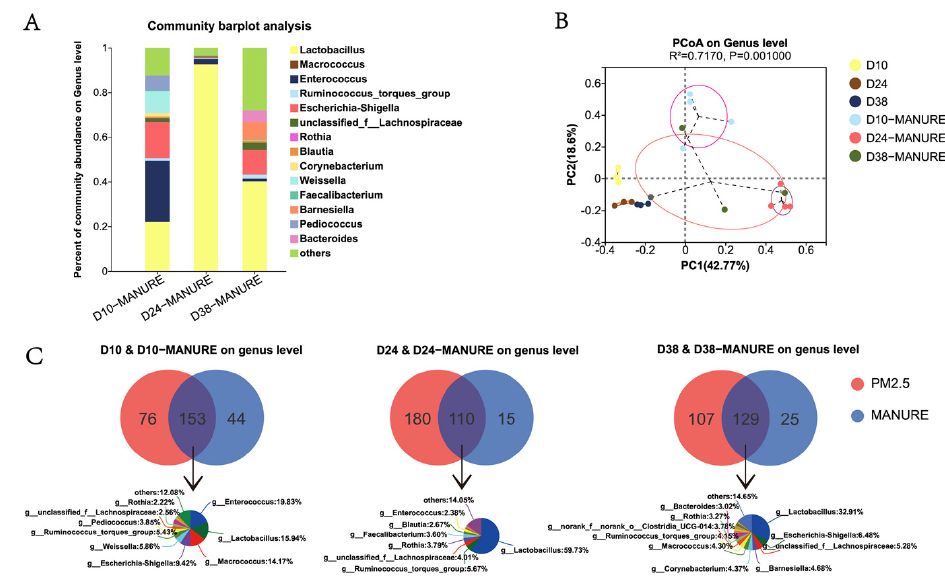
Figure 5. Manurial and indoor airborne bacterial community characteristics: ( A ) the relative abun- dance of manure at the genus level; ( B ) PCoA of community structure; ( C ) Venn diagram showing the distribution of the same and unique bacteria in feces and PM2.5 at different stages.